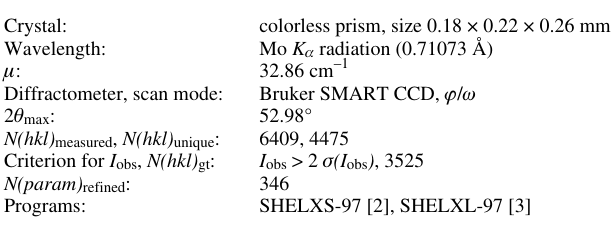
Table 1. Data collection and